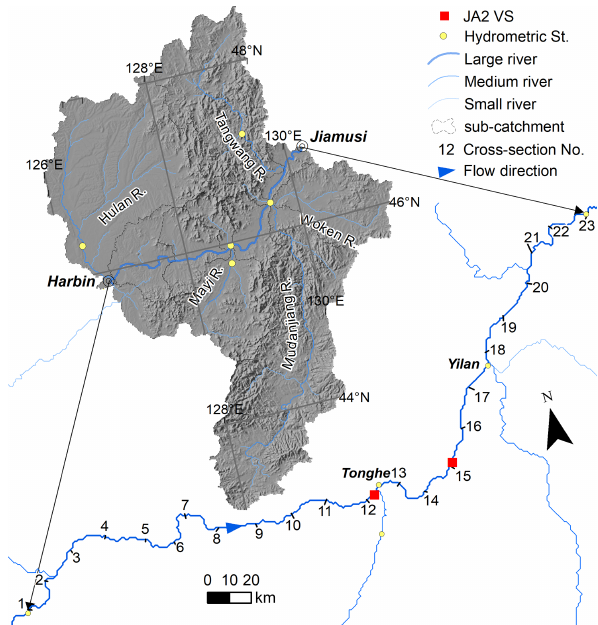
Figure 3. Overview of the study area. The studied reach is 433km long between Harbin and Jiamusi. There are five major tributaries recharging the main river. There are 23 cross-sections evenly dis- tributed along this reach as shown in the lower